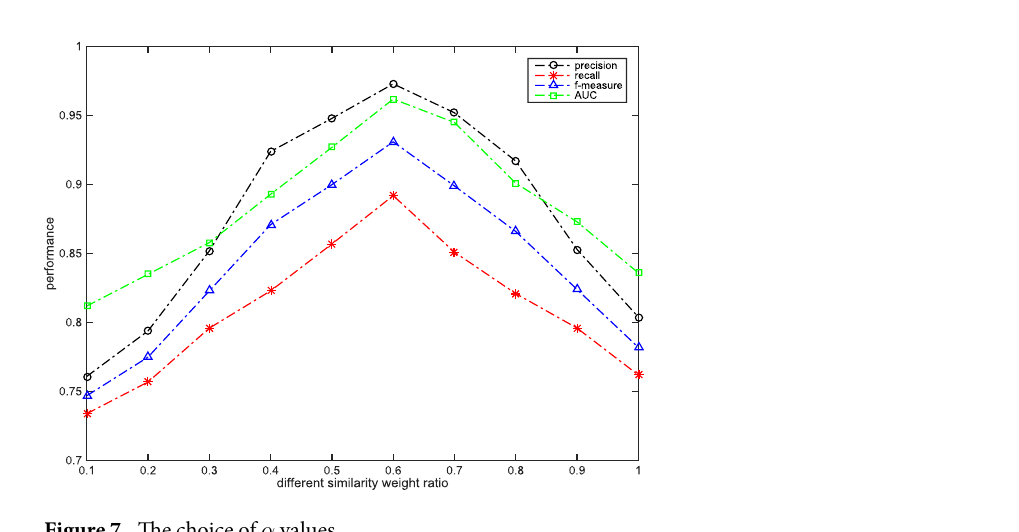
Figure 7. The choice of α